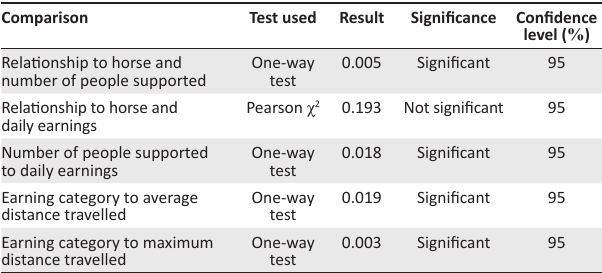
TABLE 1-A2: Statistical test results computed using